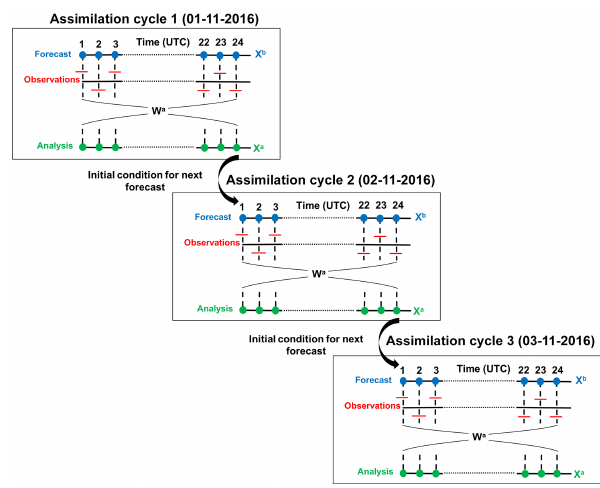
Figure 1. Schematic illustrating the three assimilation cycles of 4- D LETKF. Hourly observations are shown as red line segments for the each 24h assimilation cycle. The blue dots represent the 24h forecast that are hourly output. The green dots represent the hourly analysis within the 24h assimilation